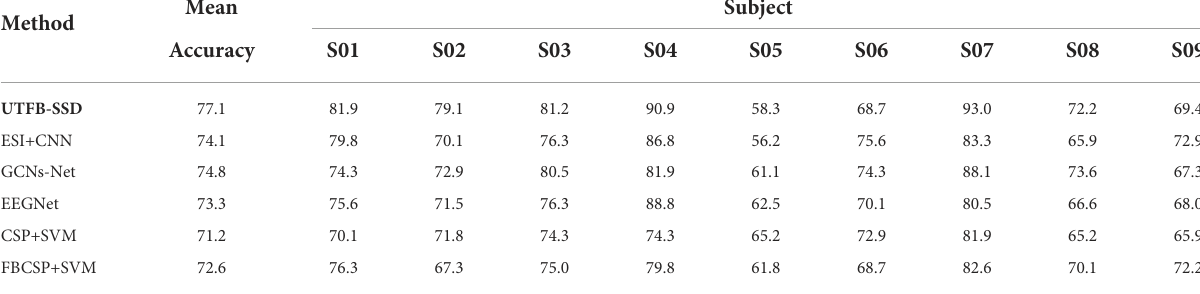
TABLE 3 Comparison of the accuracies (%) between the proposed algorithm and other methods on the BCI competition IV dataset. Method